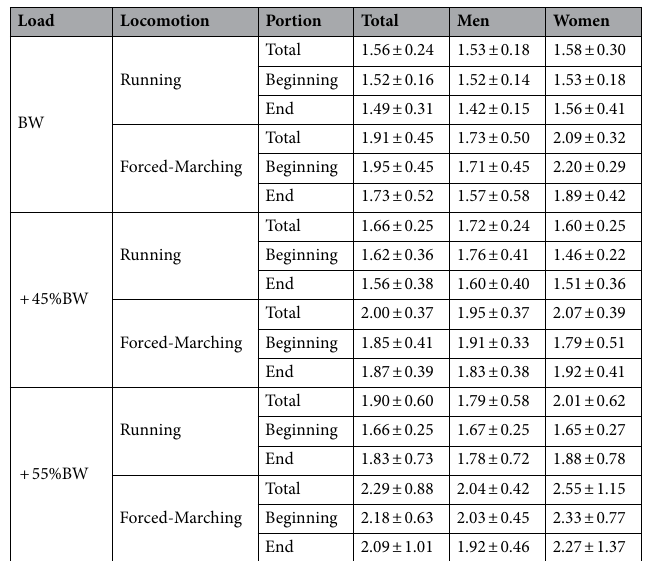
Table 3. Relative Variability. mean ± standard deviation. BW = Body weight (no load); + 45%BW = An additional 45% of BW; + 55%BW = An additional 55% of BW. Total = Entire trial; Beginning = First 30% of the trial only; End = Last 30% of the trial